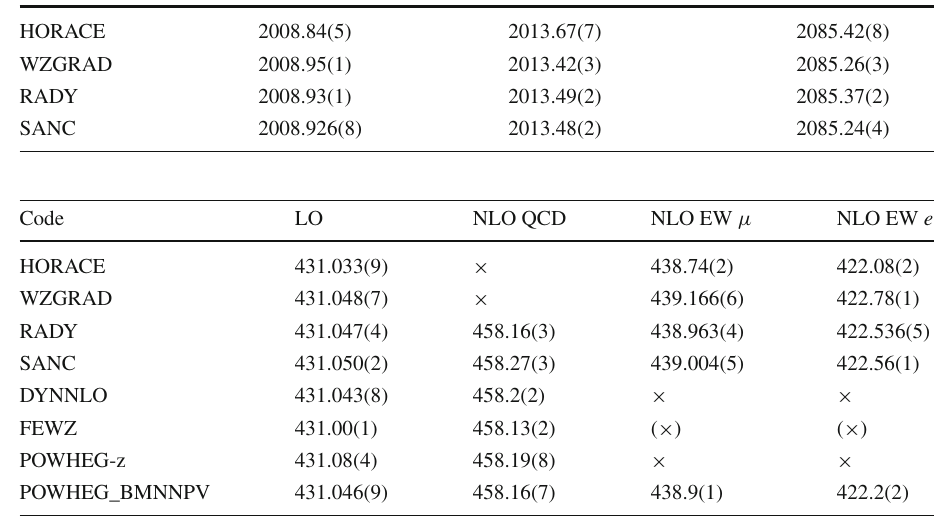
total cross sections (in pb) for pp → W − → l − ¯ ν l + X at the 8 TeV LHC, with ATLAS/CMS cuts and calorimetric leptons